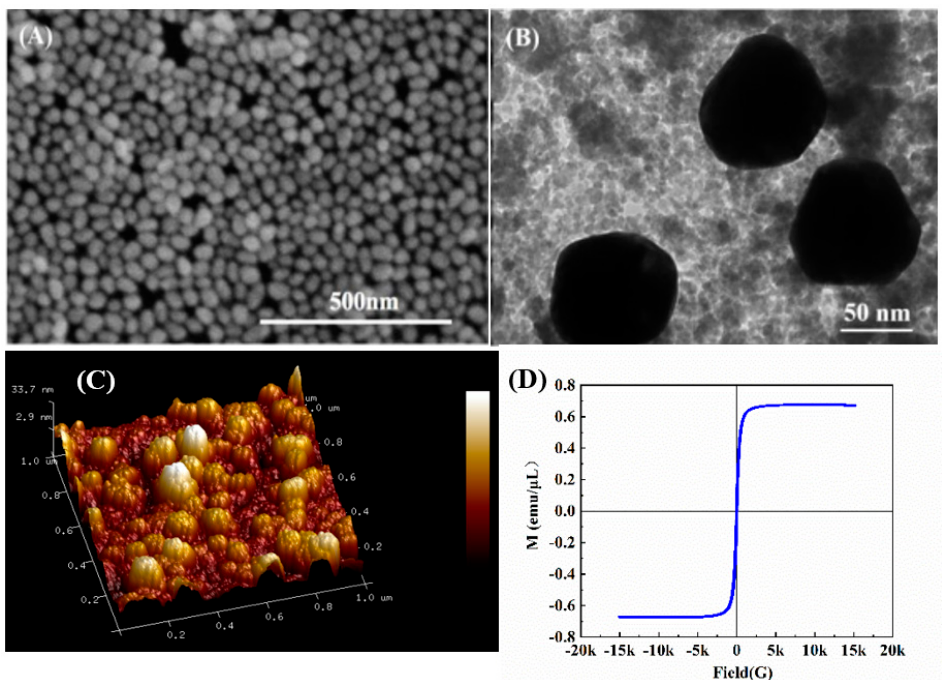
Figure 2. ( A ) SEM image of ITO/Au. ( B ) TEM image of Fe 3 O 4 @Au. ( C ) Three − dimensional AFM image of ITO/Au. ( D ) Hysteresis loop of Fe 3 O 4 @Au.